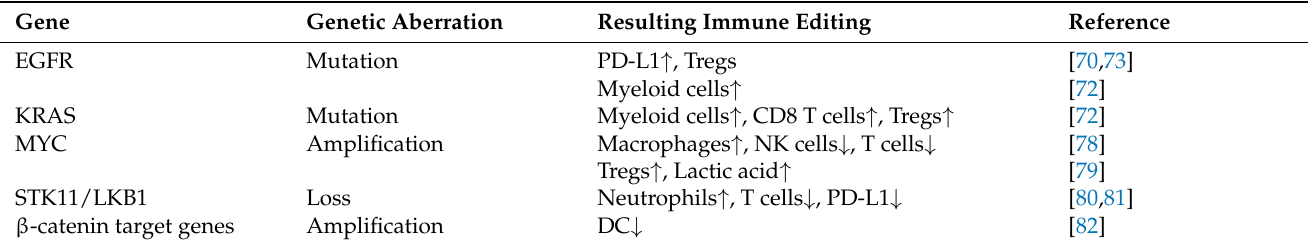
Table 1. Genetic aberrations promoting immunoediting in non-small-cell lung cancer